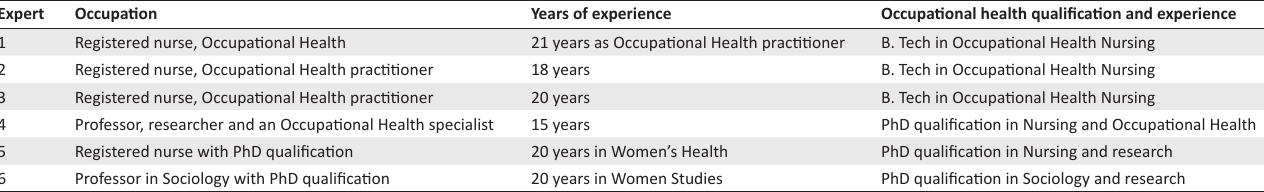
FIGURE 1: Some features of the TABLE 1: Characterisation of the experts.